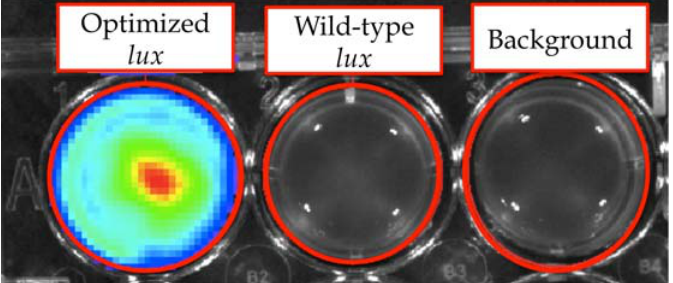
Figure 8. The optimization process employed by Close et al . was both necessary and sufficient to induce bioluminescent production from a human cell line upon